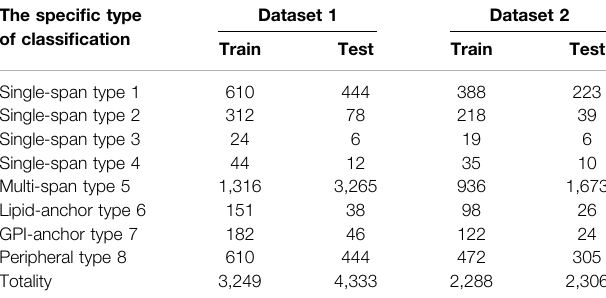
TABLE1| Thesamplesizesforthetwodifferentdatasetsusedinthisexperiment. The speci fi c type of classi fi